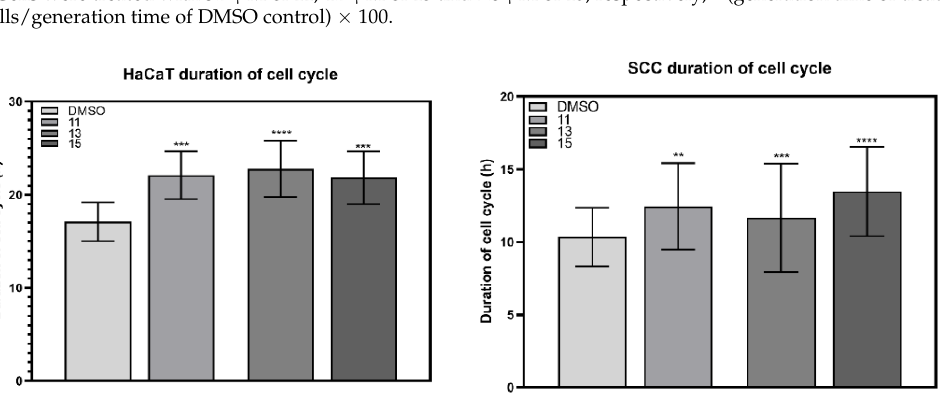
Figure 5. Effect of DMSO and compounds 11 , 13 and 15 on the generation time of HaCaT and SCC cells. (Asterisks refer to the levels of significance based on the statistical significance test; ** p < 0.01; *** p < 0.001; **** p < 0.0001; p = probability level.)